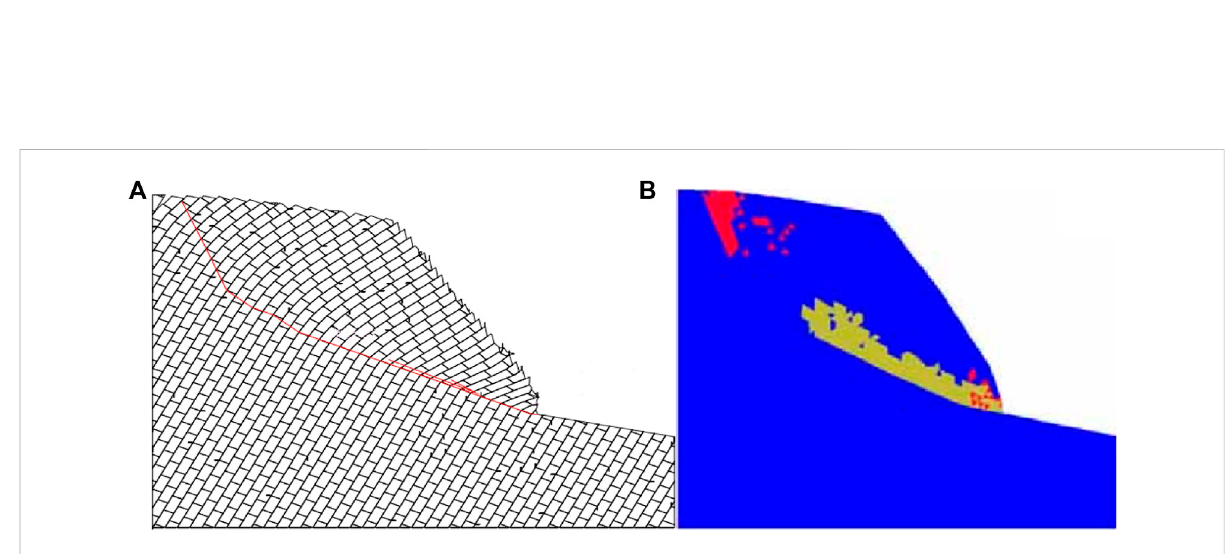
FIGURE 18 Results of Yangtai slope obtained by Liu (Liu, 2012): (A) the failure surface using UDEC; (B) distribution of plastic zone using FLAC3D.